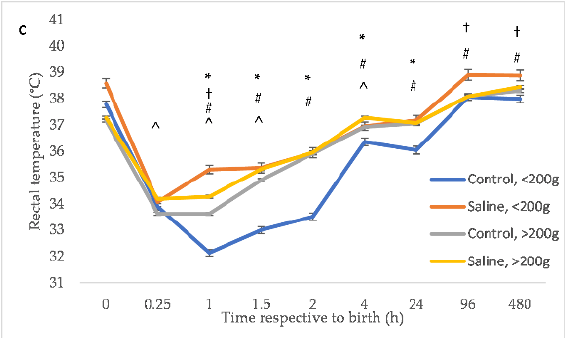
Figure 2. Mean ± standard error for the piglet rectal temperature for 13,330 piglet observations after